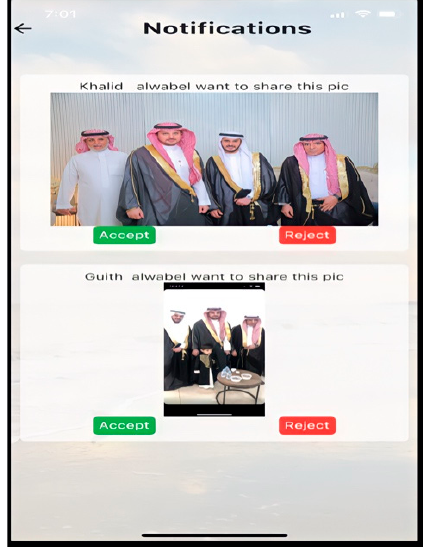
Figure 16. Recognized multiple persons.